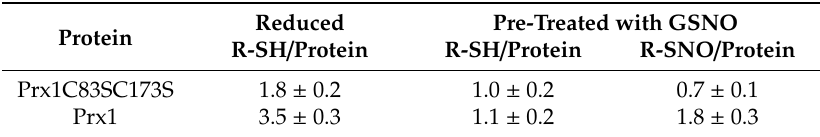
Table 1. Summary of thiol and nitrosothiol contents in reduced and GSNO-treated Prx1C83SC173S and